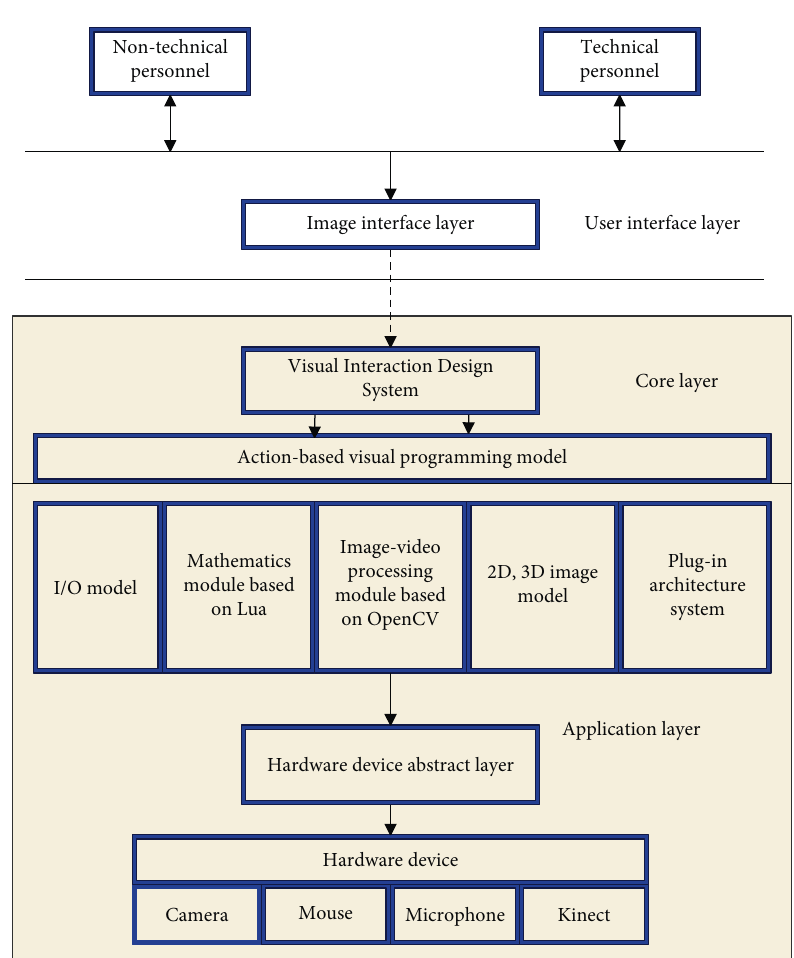
Figure 8: Crafts interactive media design platform.